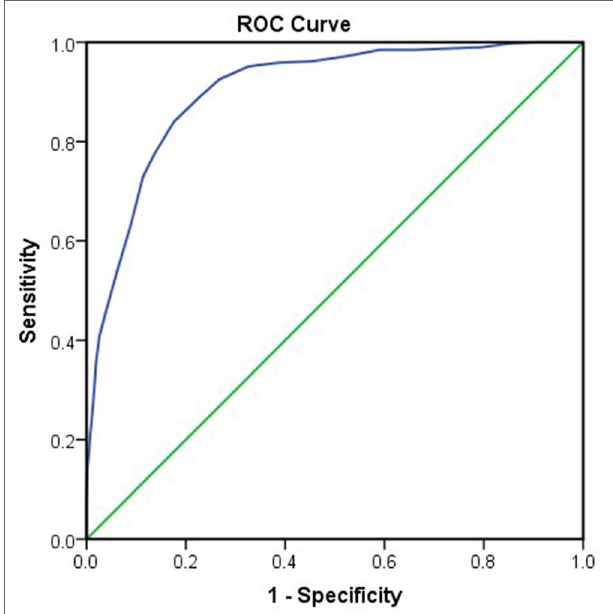
FIGURE 4 | Receiver operator characteristic (ROC) curve analysis of the 14-item